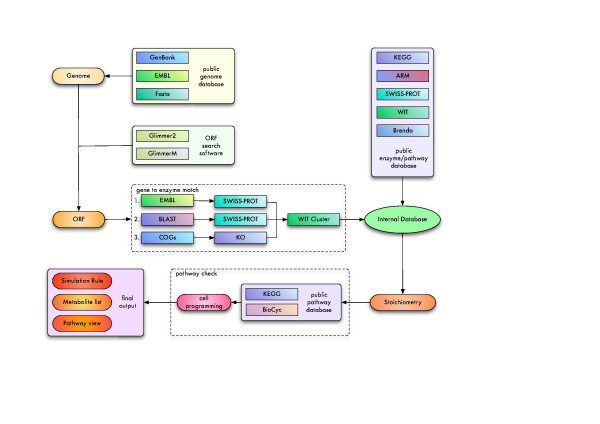
The system workflow. Starting from a genome sequence, all coding regions are matched to corresponding reaction stoichiometry for qualitative modeling, and then the reactions are quantitatively modeled with kinetic equations to generate a cell-wide simulation model.